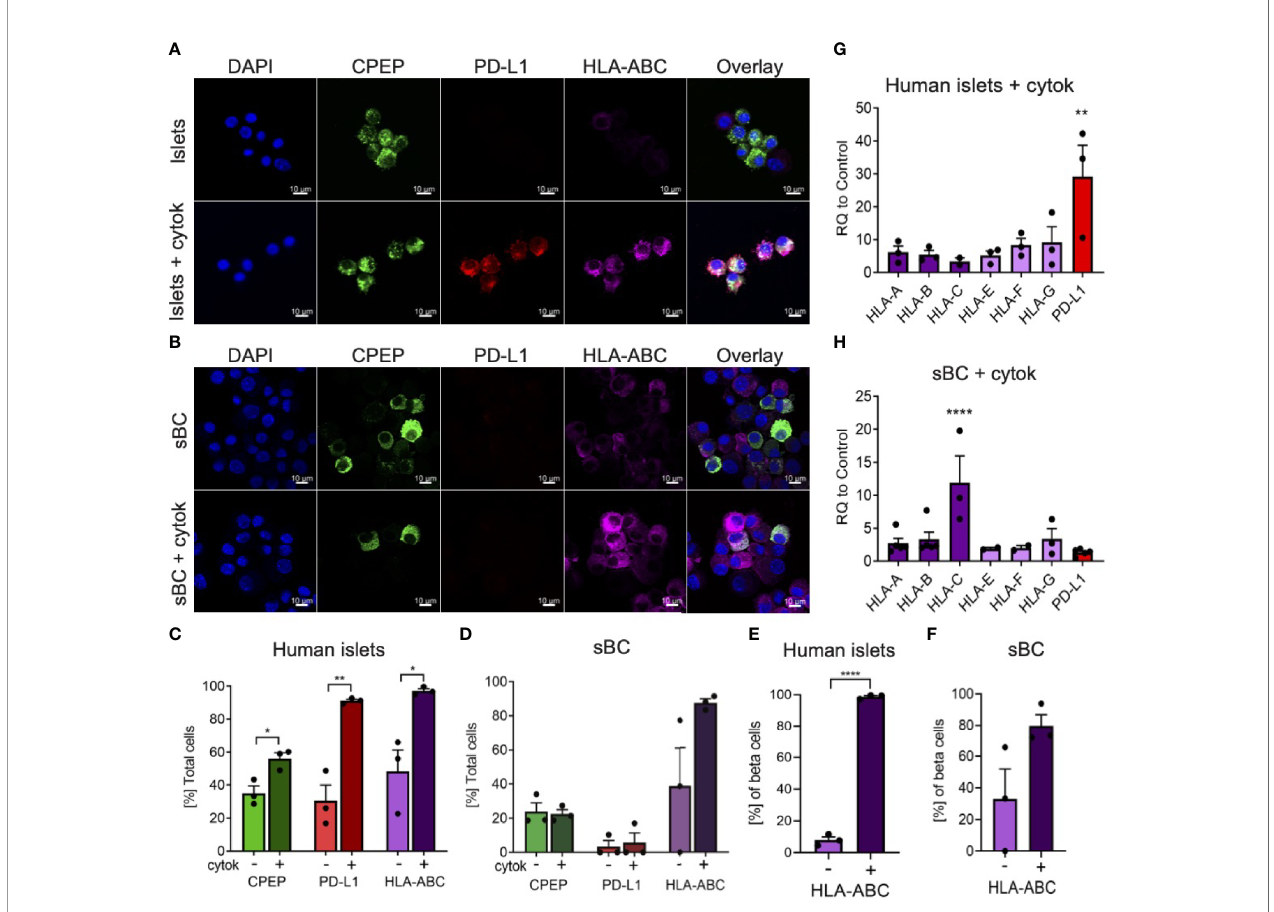
FIGURE 1 | Human islets and sBC differentially upregulate HLA class I and PD-L1 molecules upon in fl ammatory conditions. (A, B) Representative immuno fl uorescence images of control and cytokine treated human islets (A) or sBC (B) for 6 days. Samples were stained for DAPI (blue), CPEP (green), HLA-ABC (purple), and PD-L1 (red). Scale bar represents 10um. (C – F) Quanti fi cation of percentage CPEP, HLA-ABC, or PD-L1 positive cells over total cell count (C, D) or over total CPEP cell count (E, F) of control and cytokine treated human islets (C, E) or sBC (D, F). Results are shown as mean +/- SEM of n=3 independent donors. Unpaired student t test was performed with *p ≤ 0.05, **p ≤ 0.01, and ****p ≤ 0.0001. (G, H) qPCR gene expression analysis of multiple HLA class I isoforms and PD-L1 after 6 days of cytokine treatment in human islets (G) or sBC (H) . Values are normalized to ACTB and relative to control. Results are shown as mean +/- SEM of n=3 independent donors and differentiation experiments. Ordinary One-Way Anova with Dunnett ’ s multiple test with **p ≤ 0.01, and ****p ≤